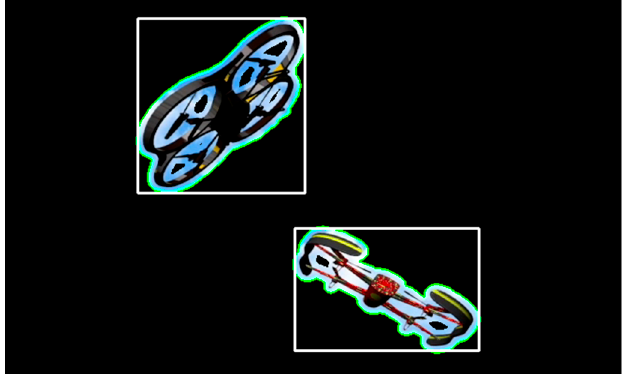
Figure 6. Moving objects bounded by the contour search method using a rectangle.